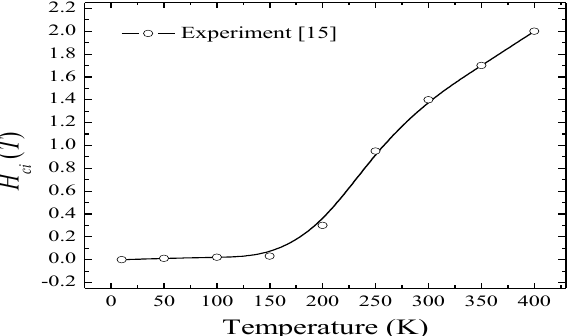
) as a function of temperature for LTP ci